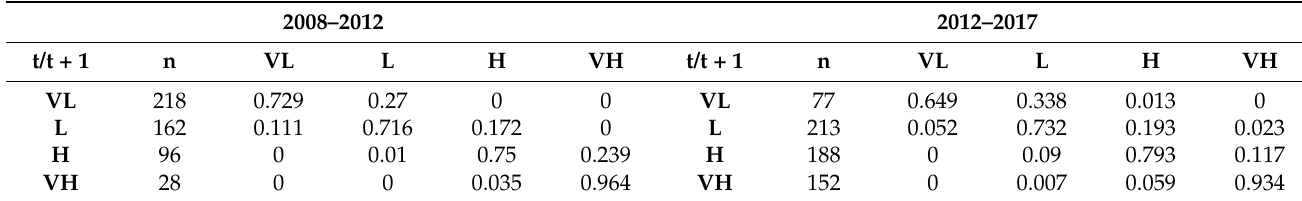
Table 3. Traditional Markov transfer probability matrix by stage for YREB.